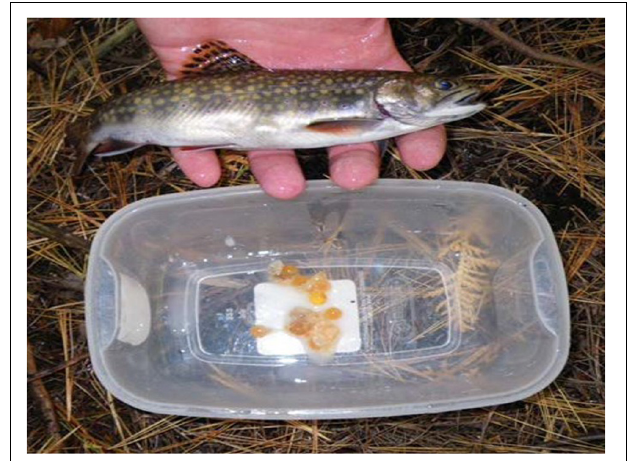
FIGURE 4 | A native brook trout that had gorged on salmon eggs in a northern Lake Michigan tributary. Photo credit: David